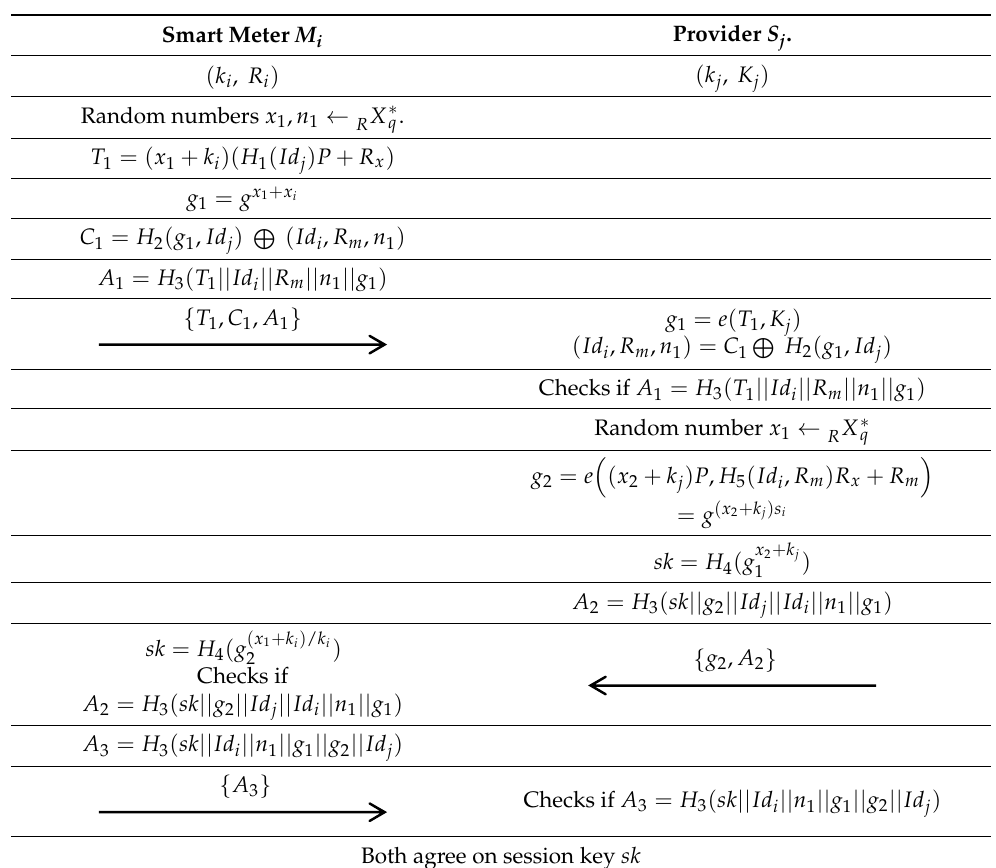
Table 4. Authentication phase of Odelu’s scheme. Table 8. Request and authentication phase of the proposed scheme. Table 8. Request and authentication phase of the proposed scheme.